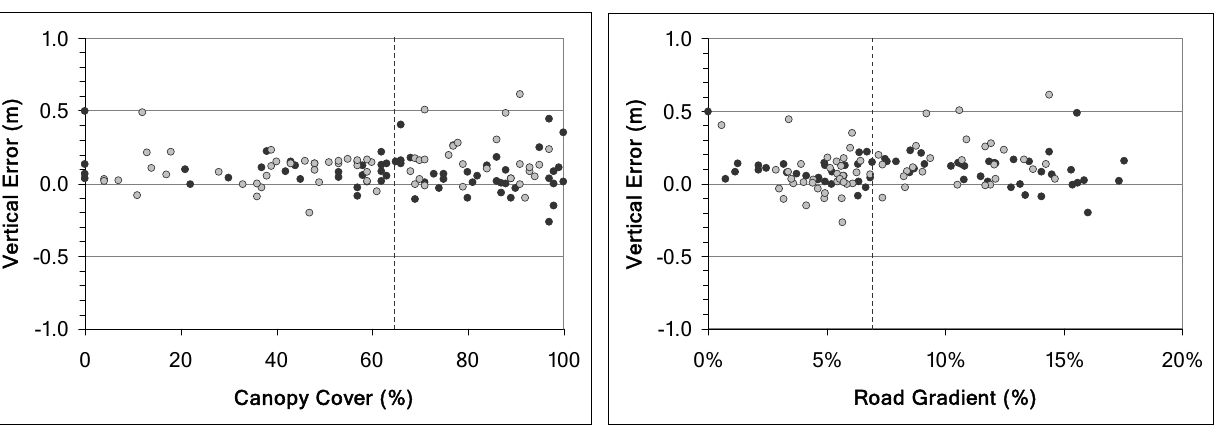
Figure 8. Left: DEM elevation error versus canopy cover. Grey points denote errors within high slope group. Right: DEM elevation error versus road gradient. Grey points denote errors within the high canopy cover group. Dashed vertical line denotes division between